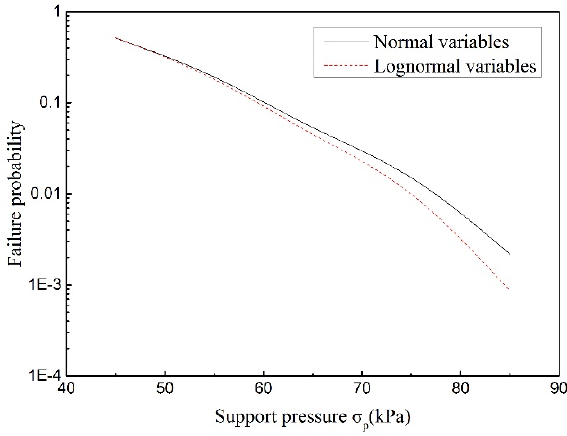
Figure 7. The effect of support pressure on failure probability.